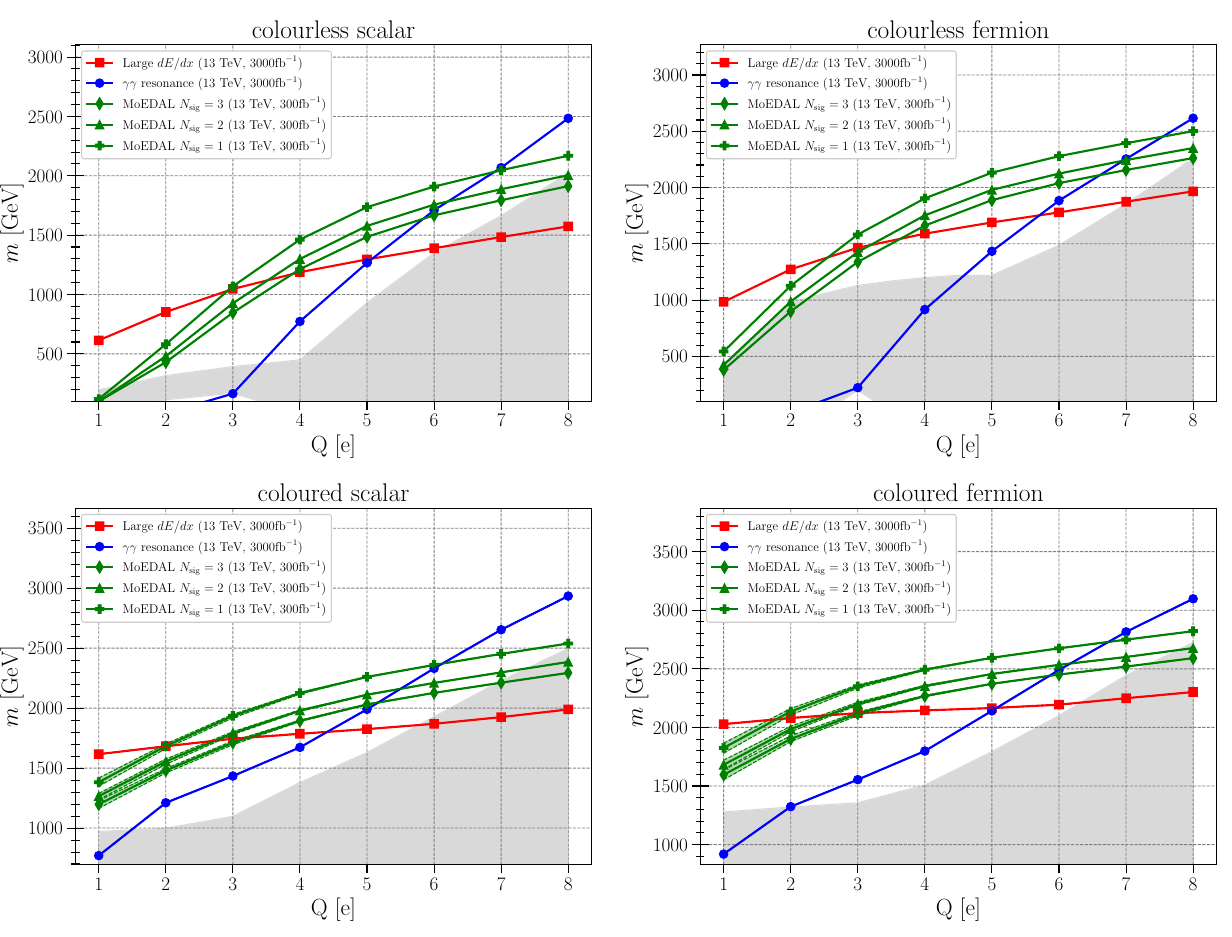
Fig. 13 Expected lower mass limits on BSM particles: colourless scalars (top left), colourless fermions (top right), coloured scalars (bot- tom left) and coloured fermions (bottom right); scaled up to HL-LHC luminosity.IntegratedluminosityforATLAS/CMSwas L = 3000 fb − 1